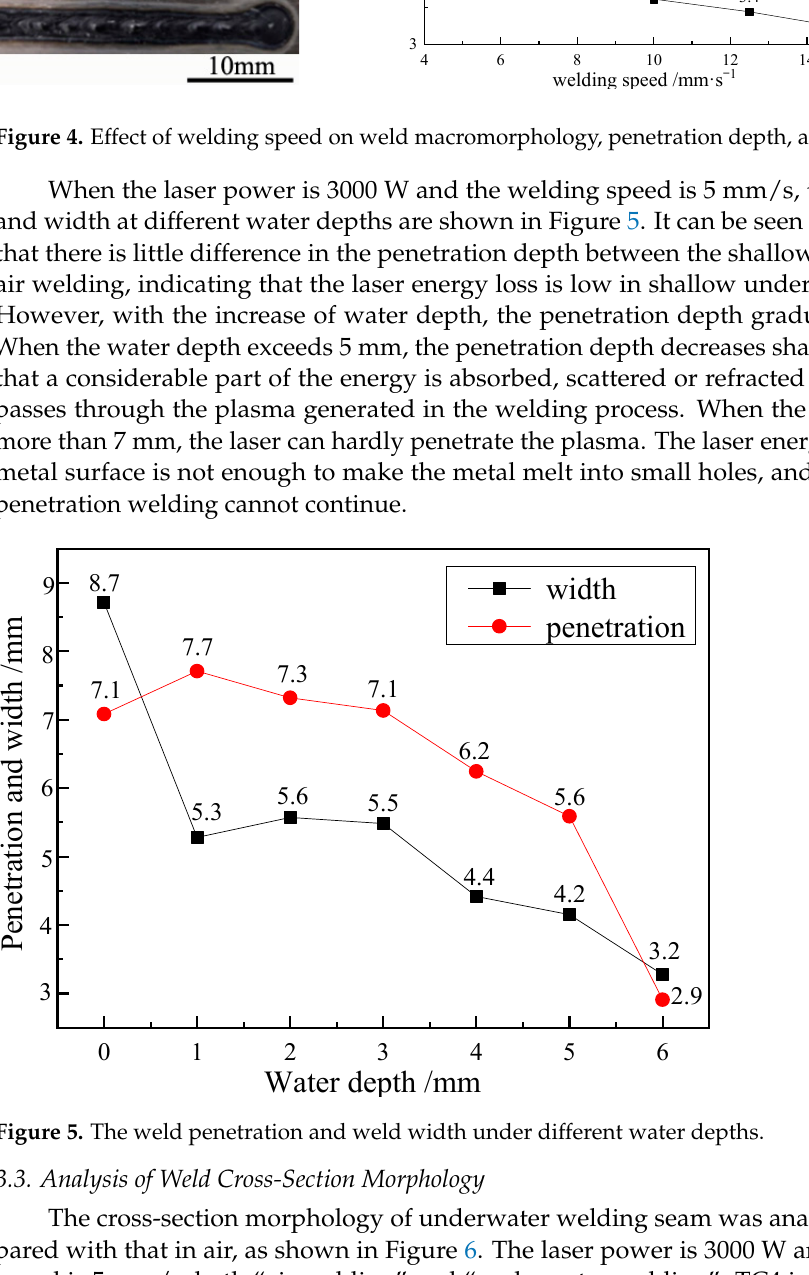
Figure 5. The weld penetration and weld width under different water depths.